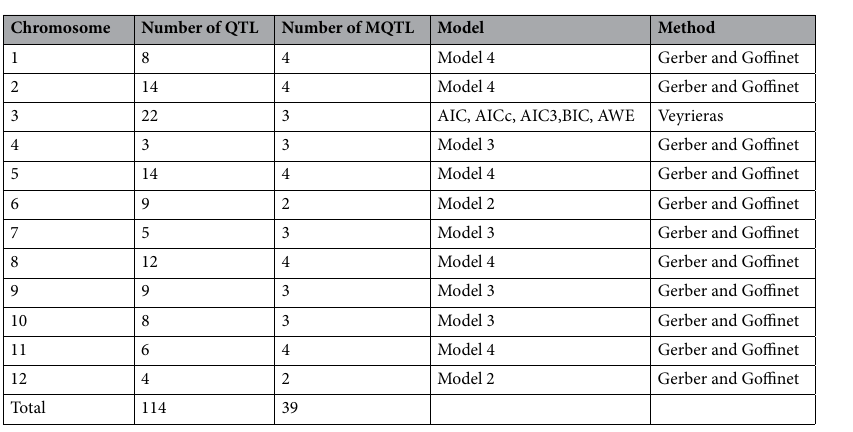
Figure 3. Detailed information on initial QTL utilized for QTL-meta analysis ( A ) chromosome distribution of initial QTL ( B ) LOD score information of initial QTL and (C) information on phynotypic variation explained by initial QTL considered for the study.